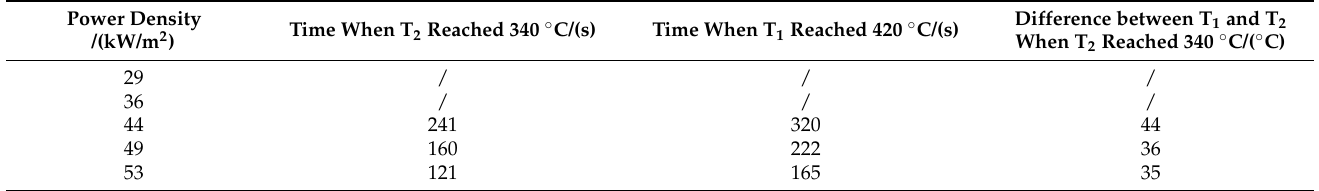
Table 3. Welding time at specific temperatures and temperature differences at the joining interface obtained with type A heating element at different power densities.